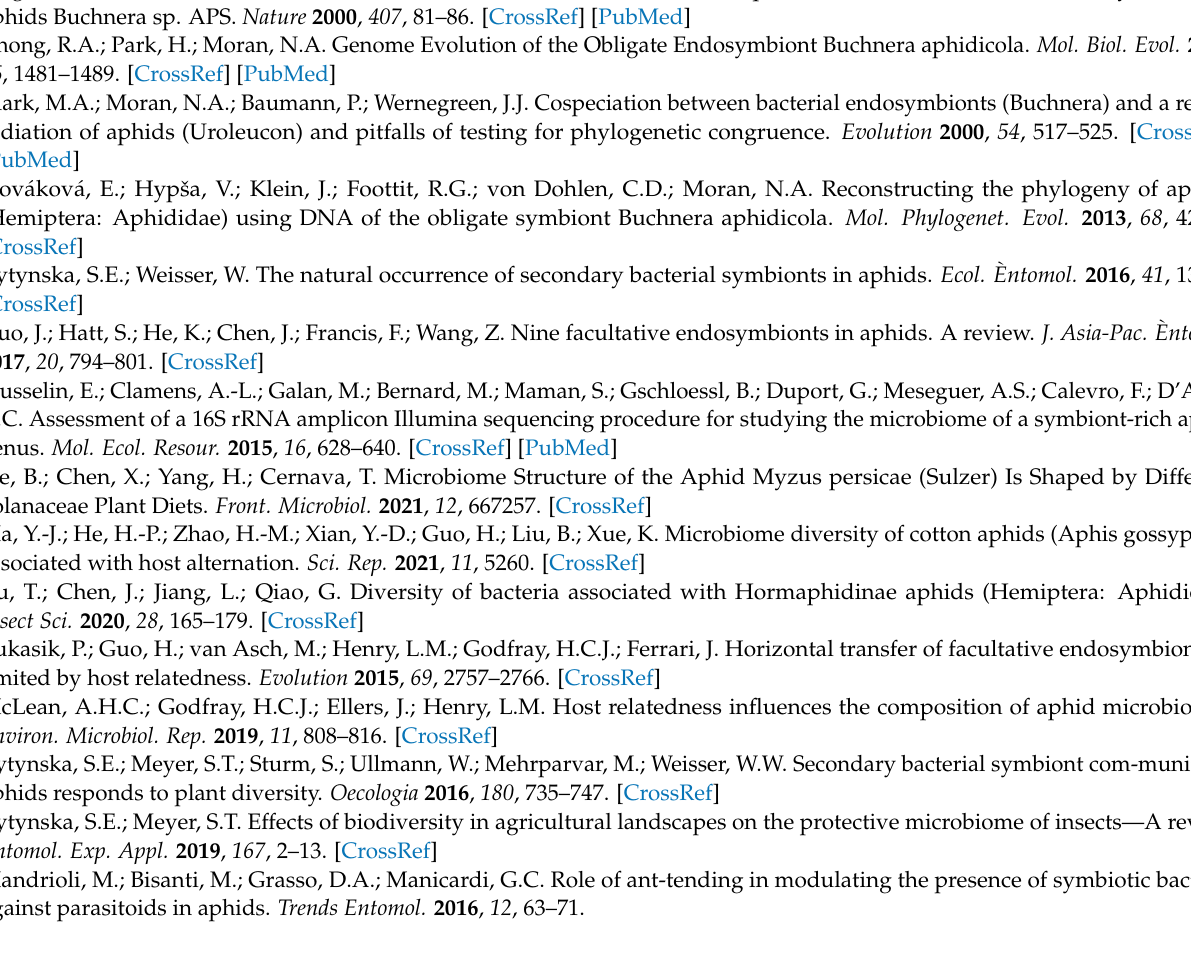
Table S2—Observational statistics per sample; Table S3—Relative abundance of symbionts in studied